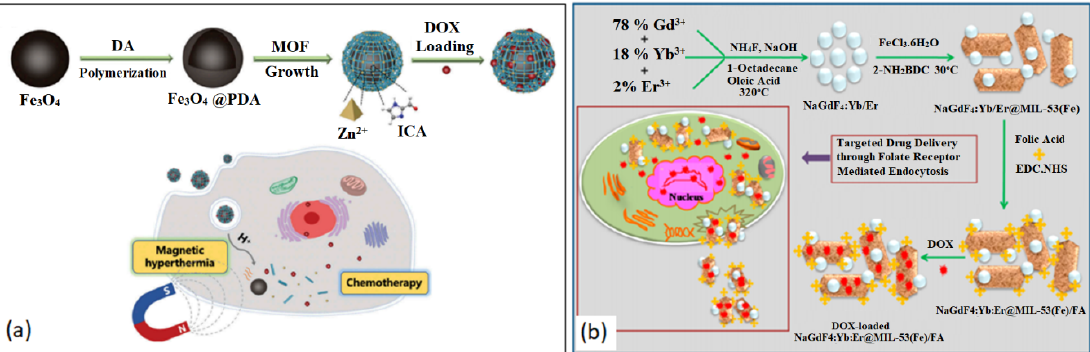
Figure 10. Examples of magnetically responsive chemically modified BioMOF nanostructures. ( a ) Fe 3 O 4 @PDA@ZIF-90 core–shell NPs. Reproduced with permission from Ref. [186]. Copyright © 2019, Taylor & Francis Online. ( b ) DOX-loaded NaGdF 4 :Yb/Er@MIL-53(Fe)/FA. Reproduced with permission from Ref. [187]. Copyright © 2020, American Chemical Society.